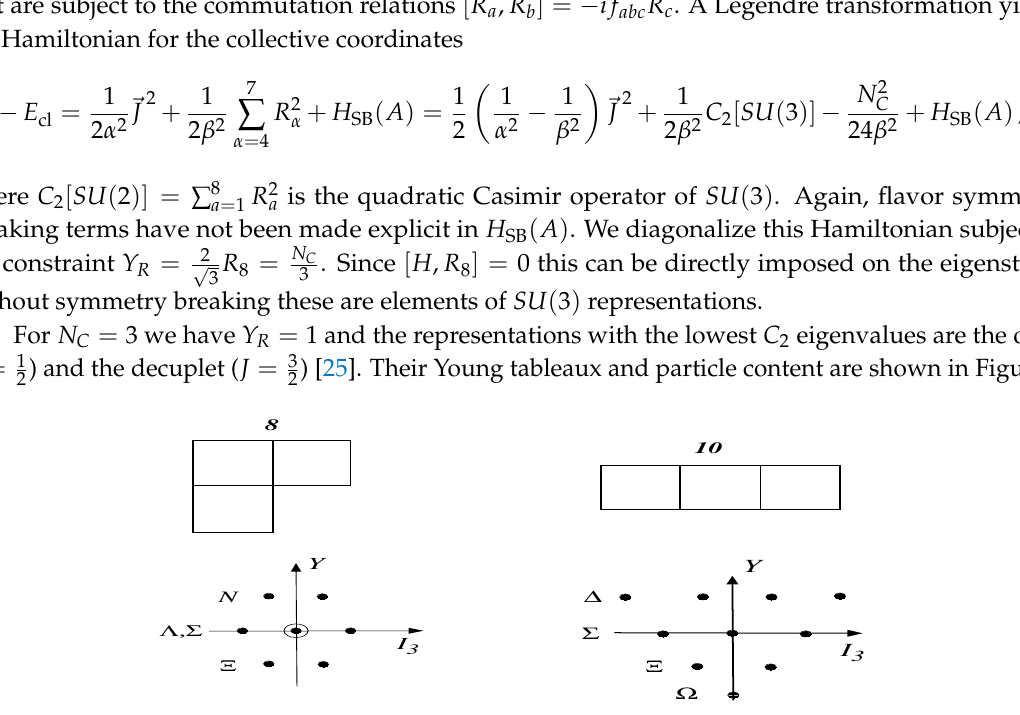
Figure 1. Young tableaux and particle content of the low-lying SU ( 3 )